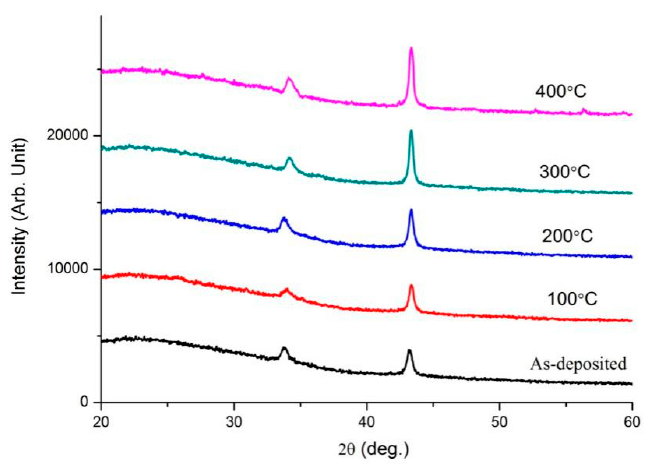
Figure 2. XRD spectra of ZnO(Cu) film system with varying annealing temperature.